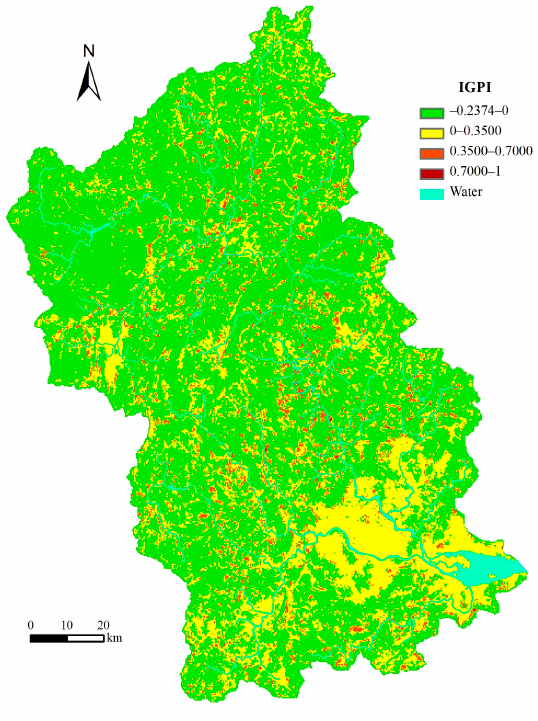
7 Figure 7. The prediction results of IGPI after regulation of the Jiulong River watershed. Table 5. The area changes of NPS pollution CSAs after regulation in the Jiulong River watershed.